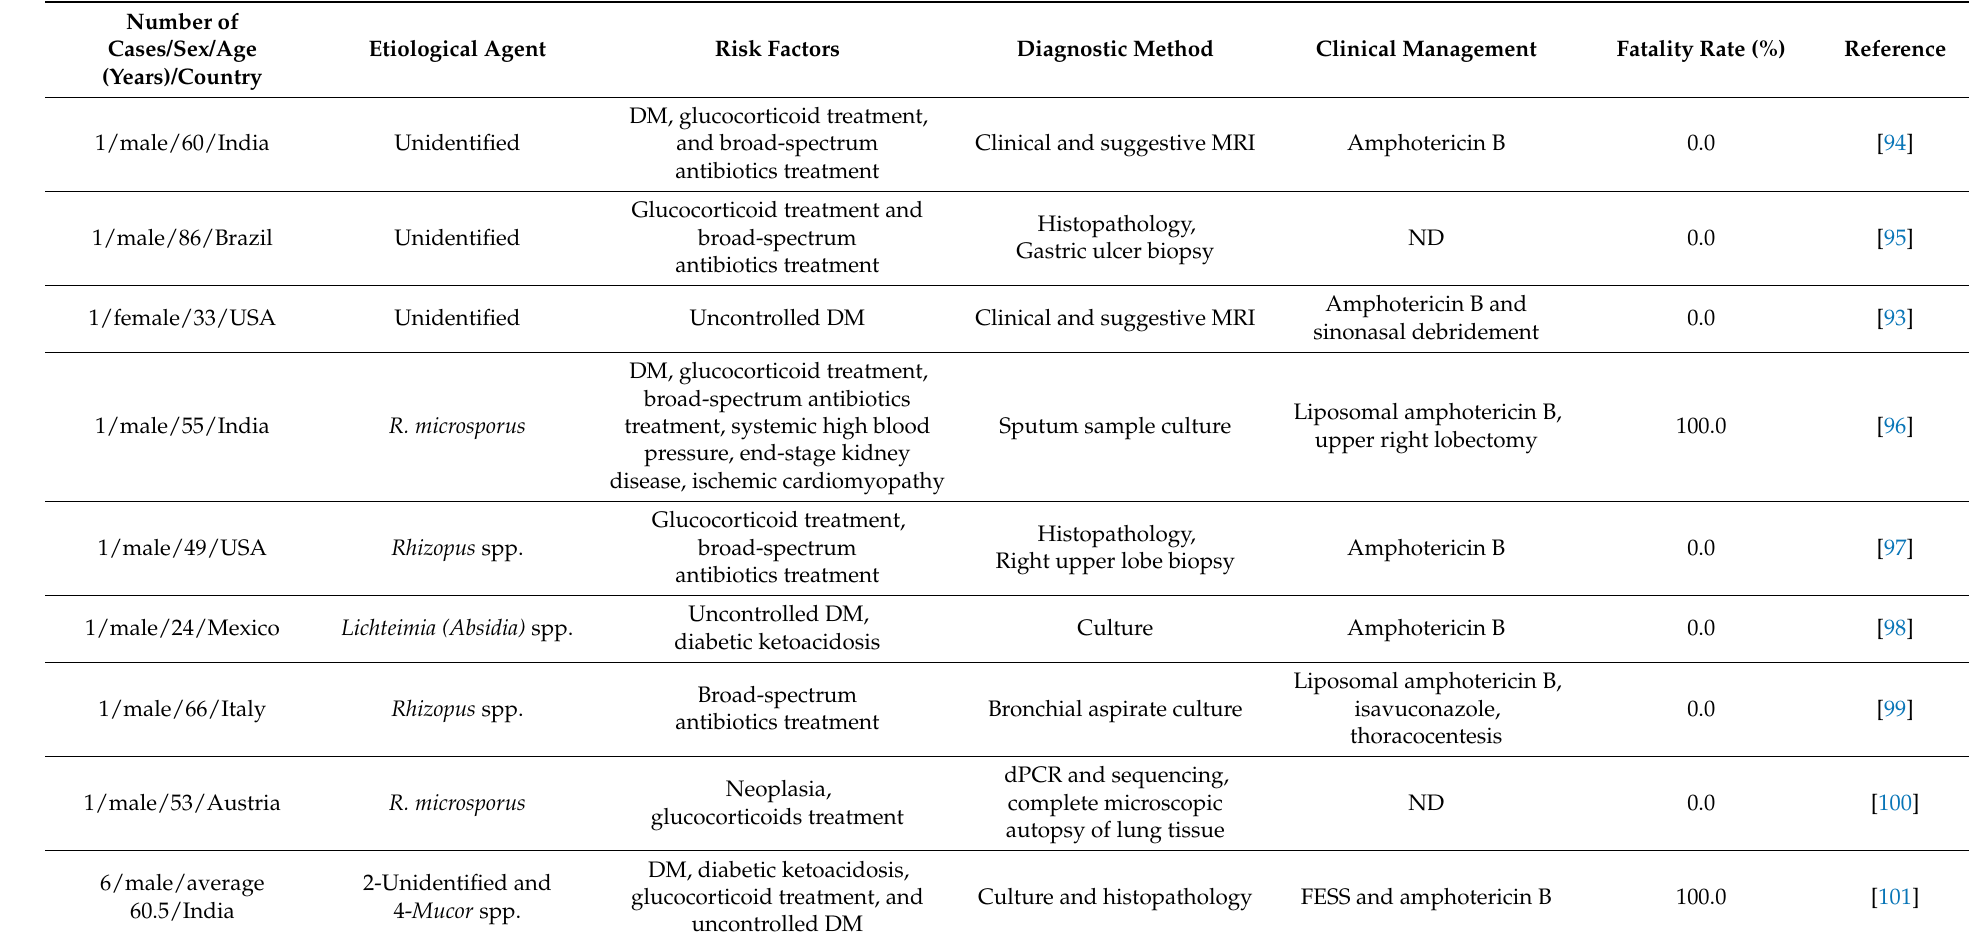
Table 4. Cases of COVID-19 and mucormycosis